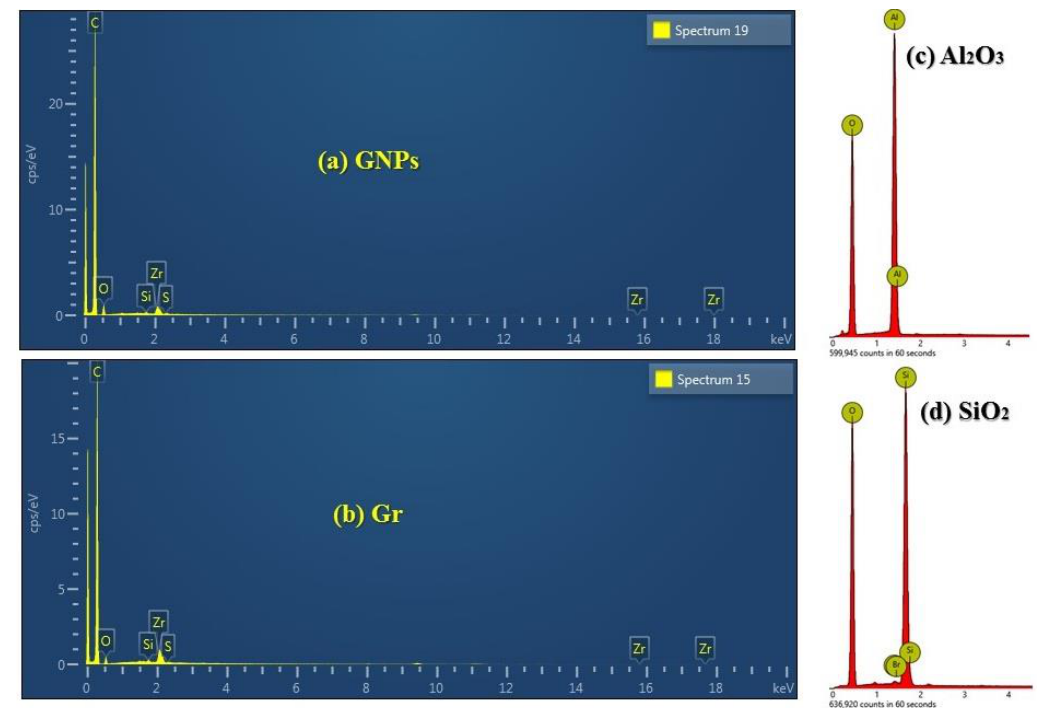
Figure 4. EDX images of different nanoparticles; ( a ) Graphene nanoplatelets, ( b ) Graphene, ( c ) Alu- mina, ( d ) Silica.